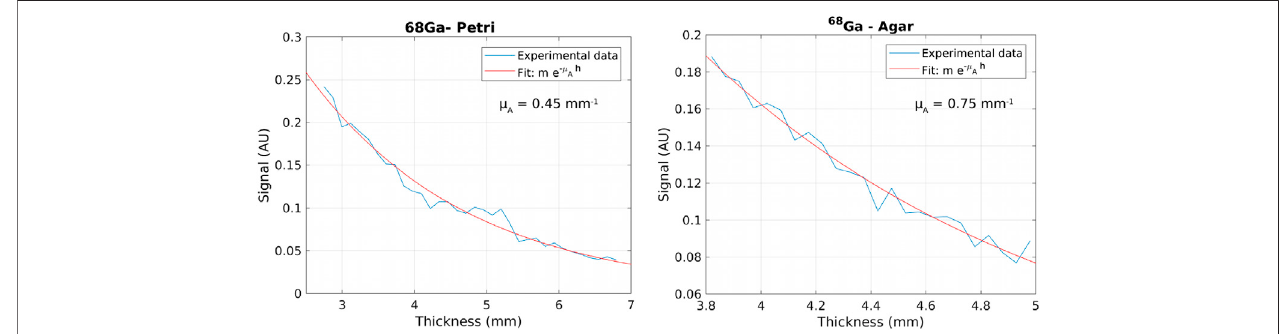
FIGURE4| Examplegraphofthesignalattenuationwithdepthintheliverobtainedfromawedgeimagefor 68 GainaPetridish (left) andinanagarphantom (right) . The exponential fi t is also shown in red.